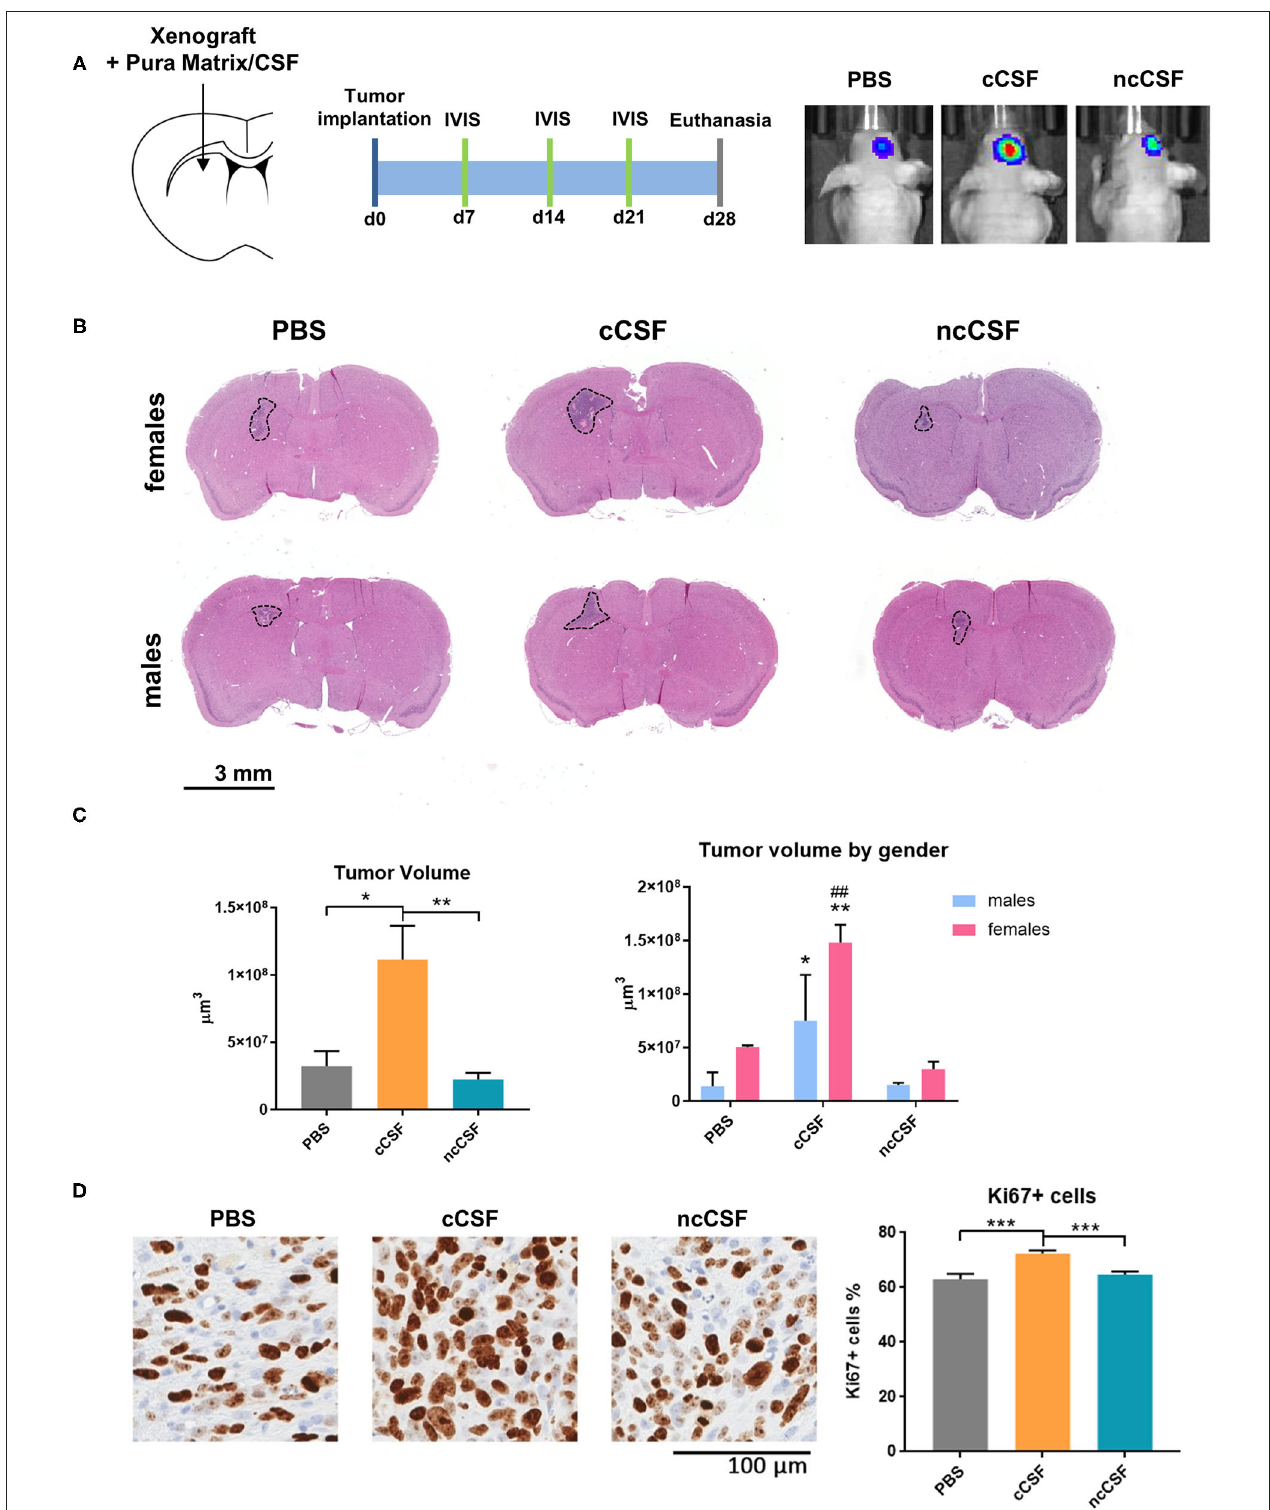
FIGURE 5 | CSF promotes GBM growth in vivo. (A) Schematic representation of the in vivo study design, showing injection site and timeline of the experiment. (B) Implanted tumor size. Mice receiving GBM cells co-injected with cCSF harbored larger tumors compared to the other groups. Interestingly, female mice developed bigger tumors than males. (C) Quantification of the tumor volumes overall and segregated by female and male mice in the different treatment groups. (* p < 0.05, ** p < 0.01 for cCSF vs. PBS; ## p < 0.05 for cCSF vs. ncCSF). (D) Immunohistochemistry staining for Ki67 in xenograft. A higher percentage of KI67 + cells were observed in the cCSF coinjected cohort. Scale bars = mean ± SEM. * p < 0.05, ** p < 0.01, *** p < 0.001.